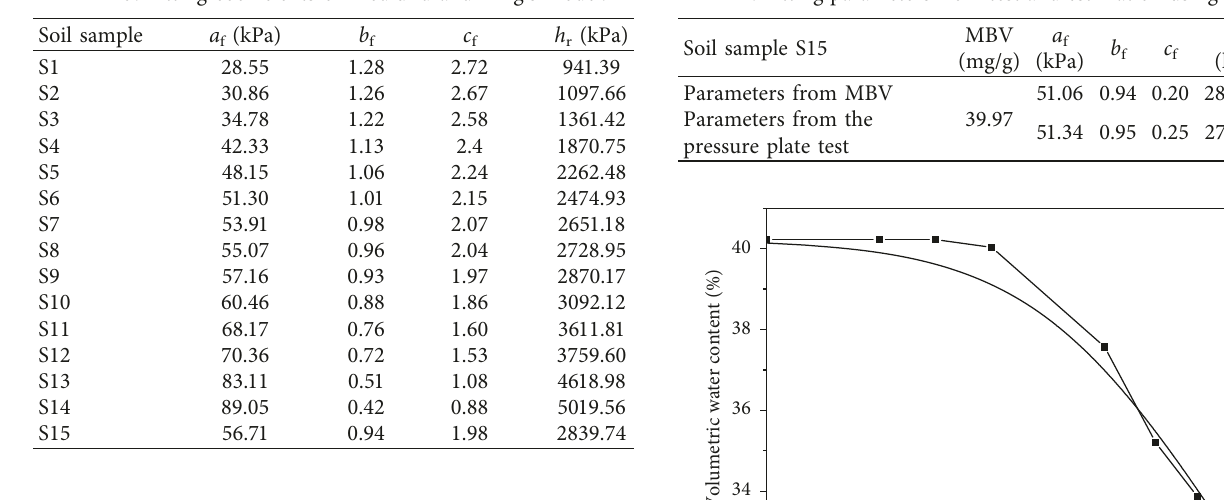
Table 4: Fitting parameters from test and estimation using MBV.